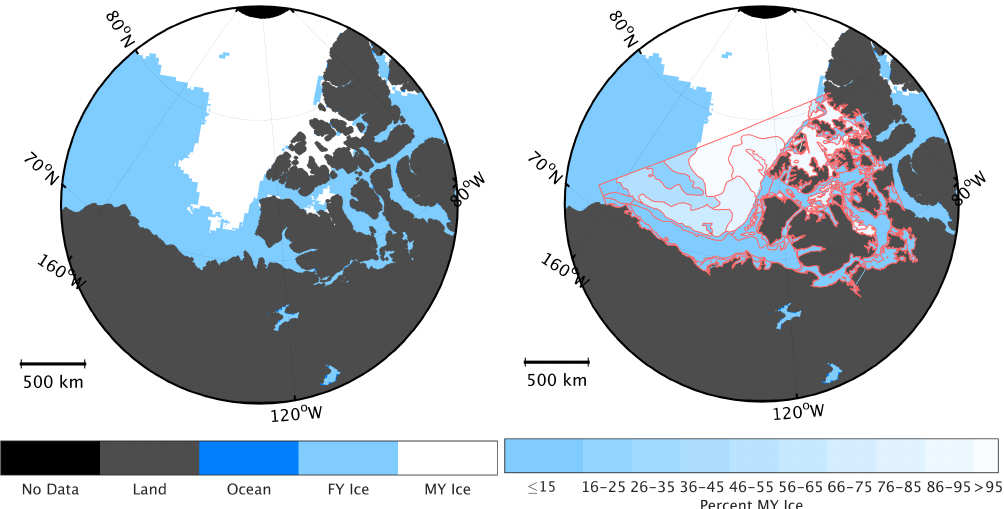
Figure 6. Images of ASCAT/SSMIS ice classifications for day of year 2, 2011 ( left ), and CIS chart classifications for day of year 3, 2011 overlaid on the ASCAT/SSMIS classifications ( right ). The data dates are offset because CIS charts are constructed using data retrieved up to 72 h prior to the reported date. In the right image, areas of the same CIS chart classification are enclosed by a red